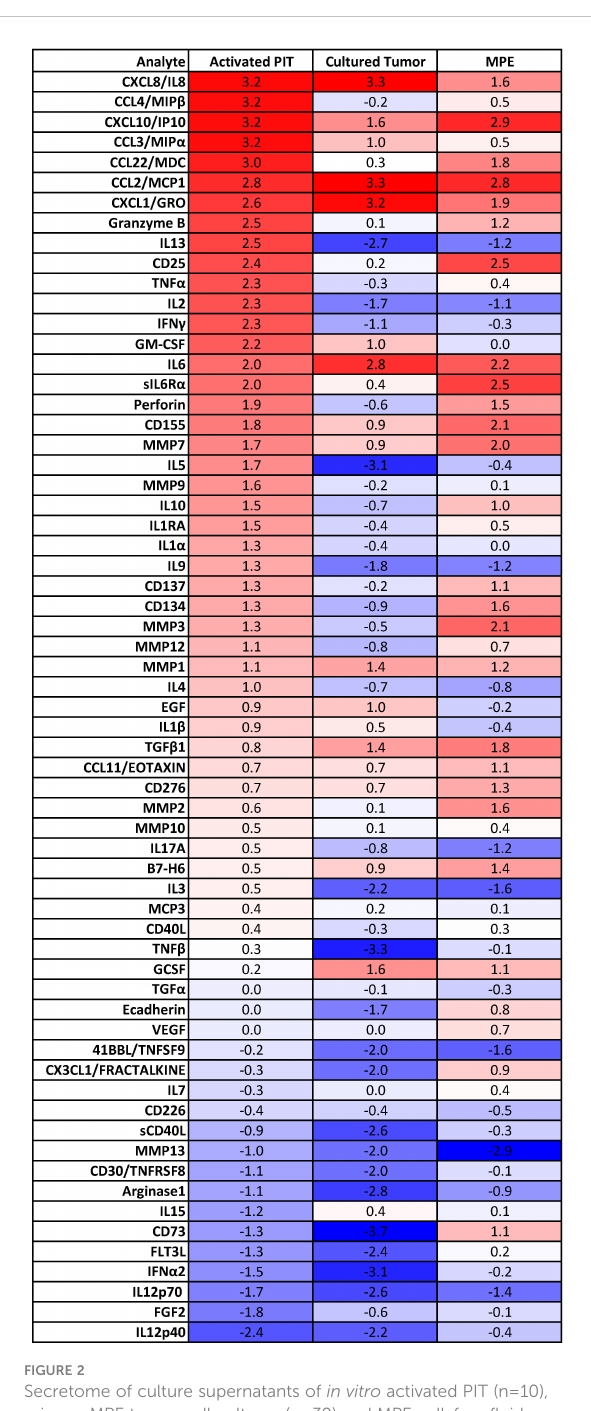
thepresence of epithelial and endothelial cells in some CD45+ fi elds. PE201 (ROI 1, red circle) and PE200 (ROI 1, blue circle) represent T-cell-rich and macrophage-rich samples, respectively (Figure 3, right panel).